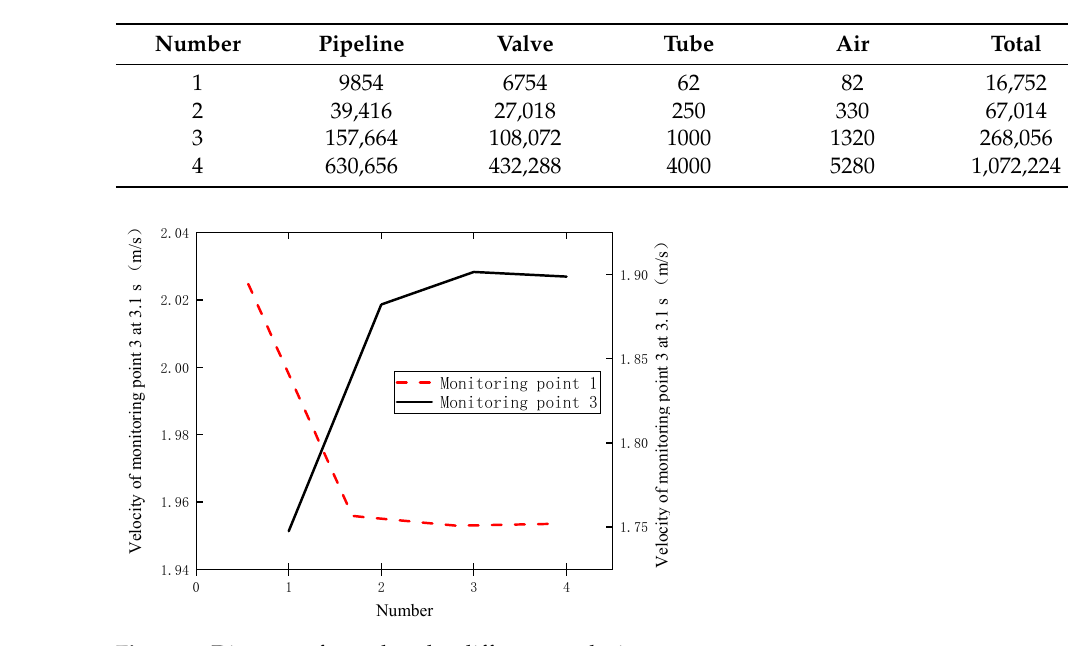
Figure 5. Diagram of speed under different mesh sizes.